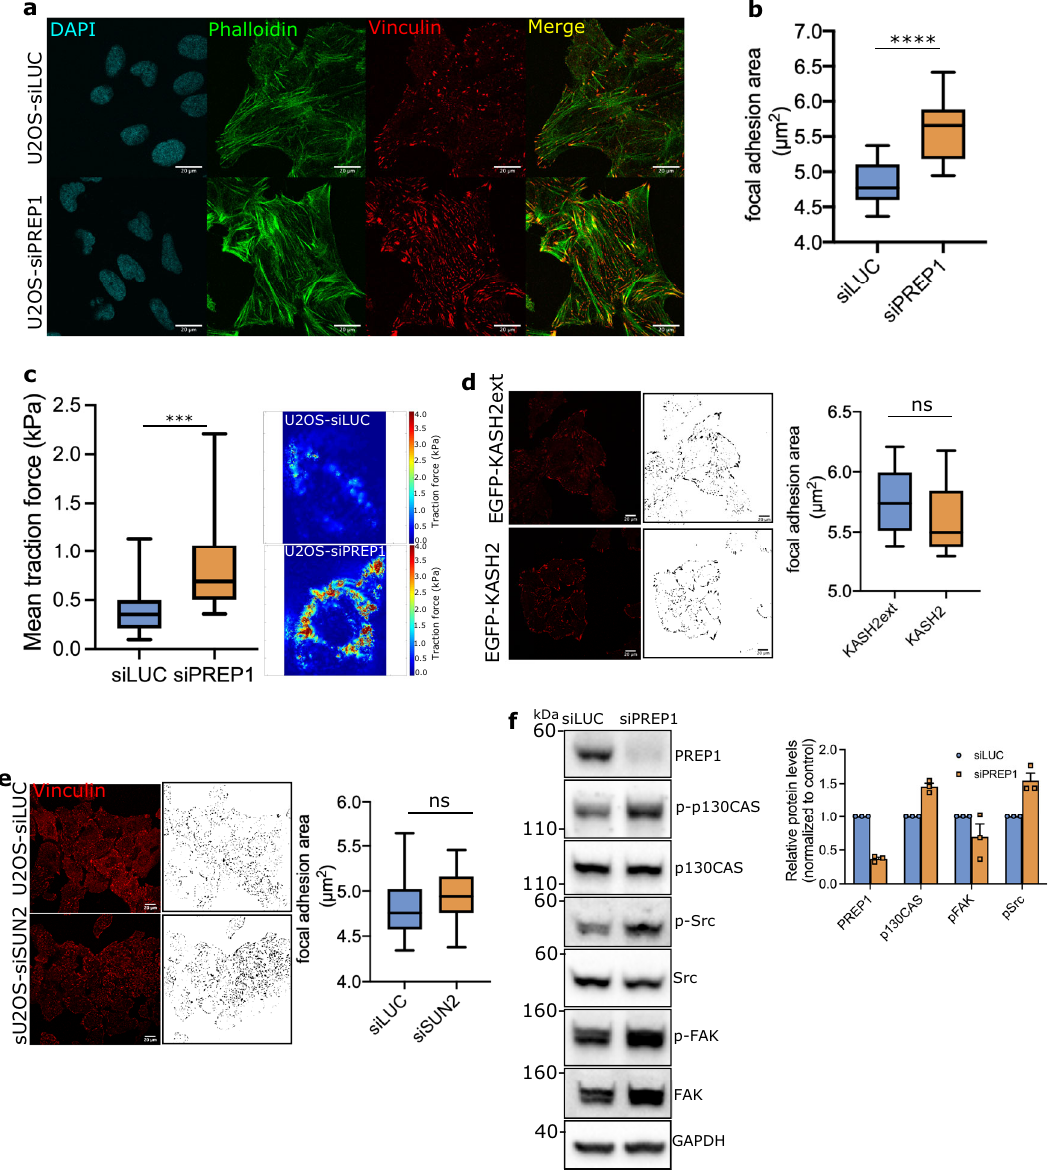
Fig. 4 PREP1 depletion affects the focal adhesion pathway. a Representative confocal images showing adhesion foci (vinculin, red) and actin stress fi bers (Phalloidin, green) in control (siLUC) and PREP1 depleted (siPREP1) U2OS cells. Nuclei are shown in blue (DAPI). Scale bar is 20 µ m. b Box and whisker plot show quanti fi cation of focal adhesion area in control (siLUC) and PREP1 depleted (siPREP1) U2OS cells. Graph is derived from four independent experiments. N = 572 cells in siLUC and 611 cells in siPREP1. c Representative traction force heat-map images of control (siLUC) and PREP1 depleted (siPREP1) U2OS cells. The box plot shows mean traction force in kPa experienced by siLUC or siPREP1 U2OS cells. The data is derived from three independent experiments. N = 25 cells each in siLUC and siPREP1 cells. d Confocal images of vinculin foci and its corresponding binary image in U2OS cells expressing EGFP-KASH2ext or EGFP-KASH2. Box plot depicts the quanti fi cation of focal adhesion area in EGFP-KASH2ext or EGFP-KASH expressing U2OS cells. Data is derived from two independent experiments. N = 101 cells in EGFP-KASH2 and 120 cells in EGFP-KASH2ext. e Confocal images of vinculin foci and its corresponding binary image in control (siLUC) and SUN2 depleted (siSUN2) U2OS cells. Box plot shows focal adhesion area in the same cells. Data is derived from three independent experiments. N = 433 cells in siLUC and 628 cells in siSUN2. f Representative immunoblot showing the phosphorylation status of p130CAS, Src and FAK proteins in whole cell lysates of control (siLUC) and PREP1 depleted (siPREP1) U2OS cells. Corresponding total protein levels and GAPDH serve as loading control. Blot is representative of three independent experiments. Bar graph shows the relative protein expression in PREP1 depleted cells normalized to control cells across experiments. Error bars denote mean ±